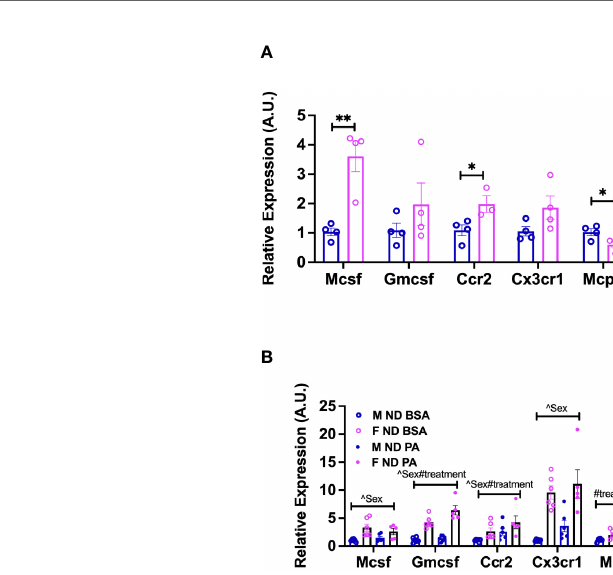
FIGURE 6 | Sex differences in the gene expression of monocyte markers upon stimulation with a SFA and chemokine. BM male and female monocyte gene expression of Mcsf, Gcsf, Ccr2, Cx3cr1, Mcp1, Tlr4, Ar, Esr1 , and Esr2 from (A) 13-week-old mice. Data were analyzed by two-sample t-test. (B) 22-week-old mice. N = 4 – 6 per condition. Data were analyzed by 2-way ANOVA followed by Tukey ’ s multiple comparisons test. Data shown as average +/- SEM. *p<0.05, **p<0.01 and ***p<0.005. Figures are marked for signi fi cance of main effects (^sex or #treatment) and